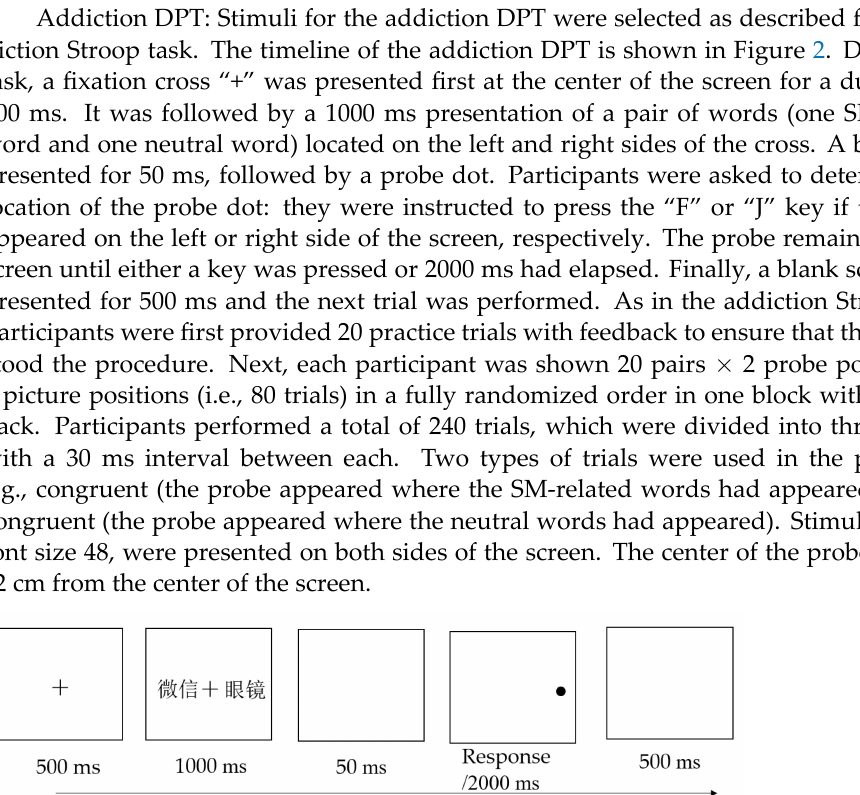
Figure 1. The timeline of the addiction Stroop task. Note: 微信 = WeChat, 眼镜 = glasses. Index of AB = mean RT of SM‑related stimuli − mean RT of neutral stimuli.